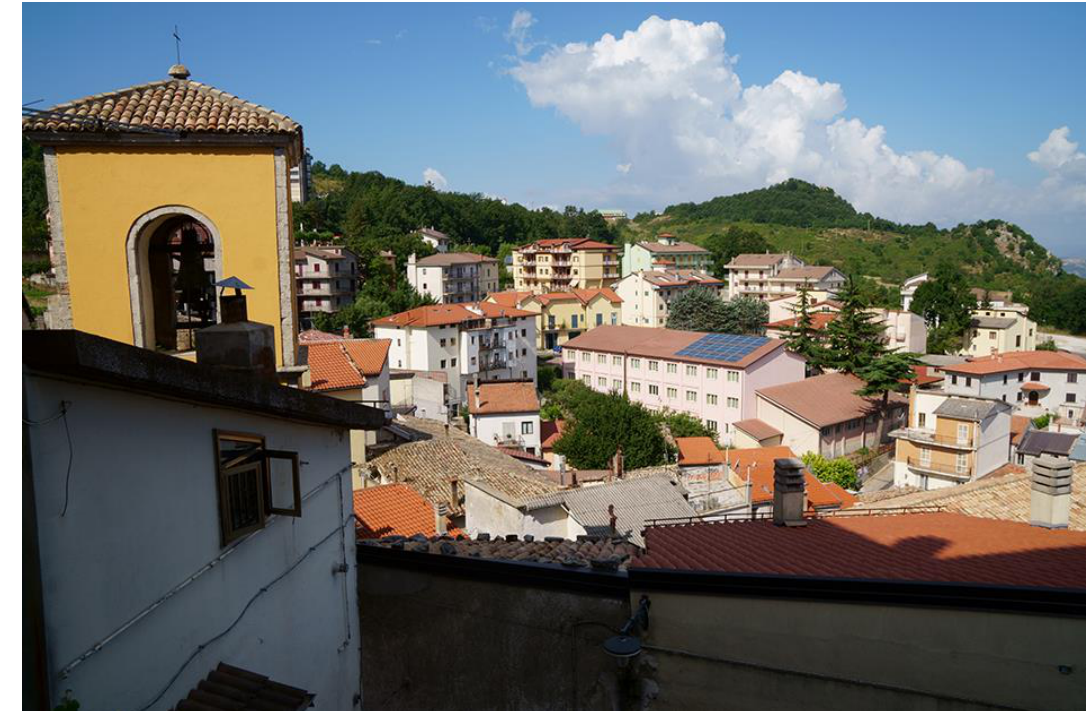
Figure 65. San Michele di Serino: detail of Cotone Street in which there were phenomena liquefaction triggered by the earthquake [22], (photos by [35,36]).